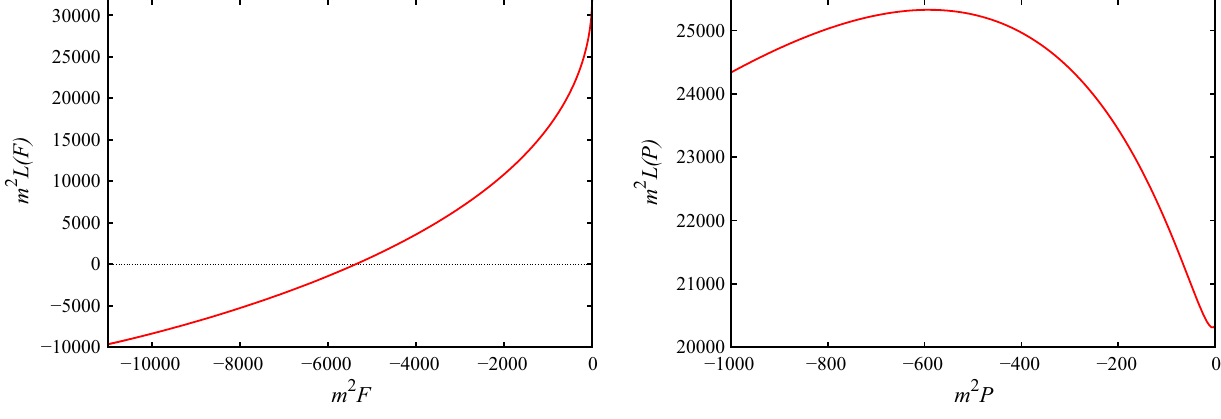
Fig. 14 Graphical representation of the electromagnetic Lagrangian in terms of the electromagnetic scalar and the auxiliary field for mc 1 = 1 and q = 0 . 7